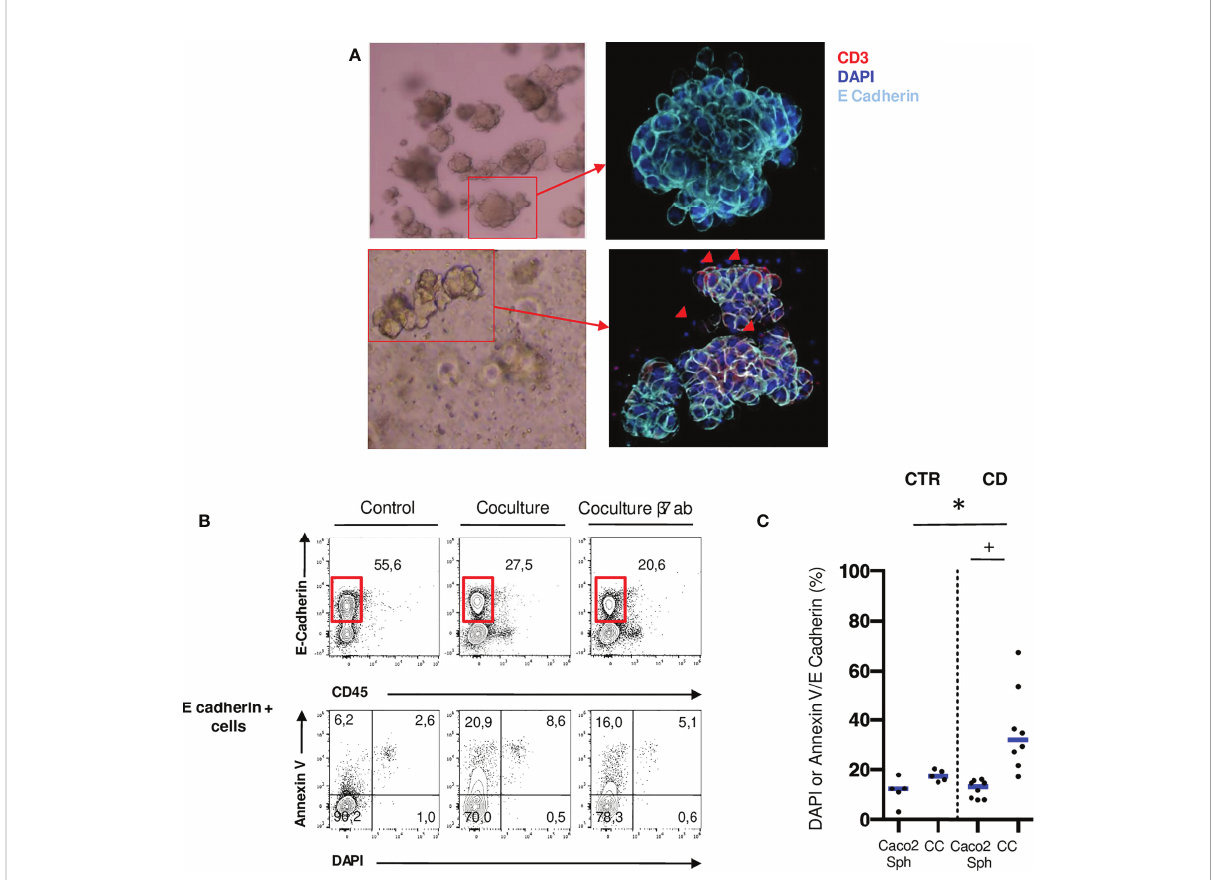
FIGURE 1 Ileal mucosal T cells from patients with active CD have an increased cytotoxic potential over Caco2 spheroids. (A) Caco2 spheroids alone or in coculture with mucosal T cells from CD patients in bright fi eld microscopy (10X) and confocal microscopy (200X: Blue: DAPI; Light Blue: E- Cadherin). Red arrows correspond to T cells in fi ltrating the spheroid (Red: CD3). (B) Gating strategy to assess Caco2 cell death with or without T cells in cocultures. Cell death was assessed through Annexin V and DAPI staining in E-Cadherin positive cells. (C) Comparison of Caco2 cells death rates between allogenic cocultures with mucosal T cells from controls and active CD patients. CD= Crohn ’ s Disease, CTR= Control. CTR: n=5; CD: n=8. * p < 0.05 Mann Whitney Test. +: p < 0.05 Wilcoxon paired